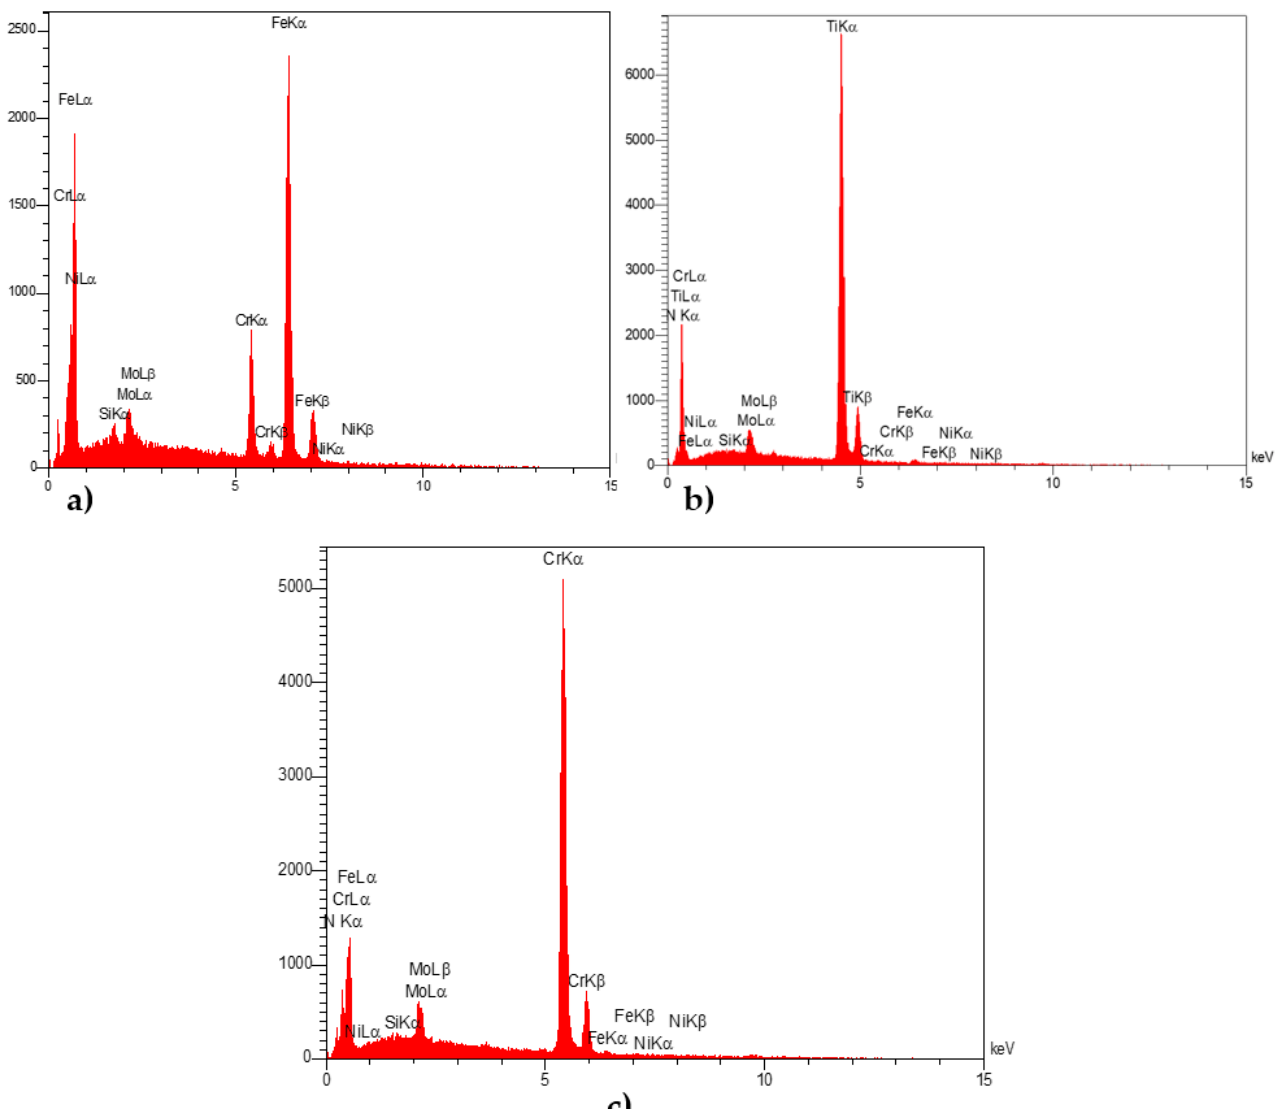
Figure 8. EDX patterns on the surface of different materials, including ( a ) SS 410 as a substrate, ( b ) TiN-coated specimens, and ( c ) CrN-coated specimens. Table 4. EDX data from the coated and uncoated specimen surfaces.